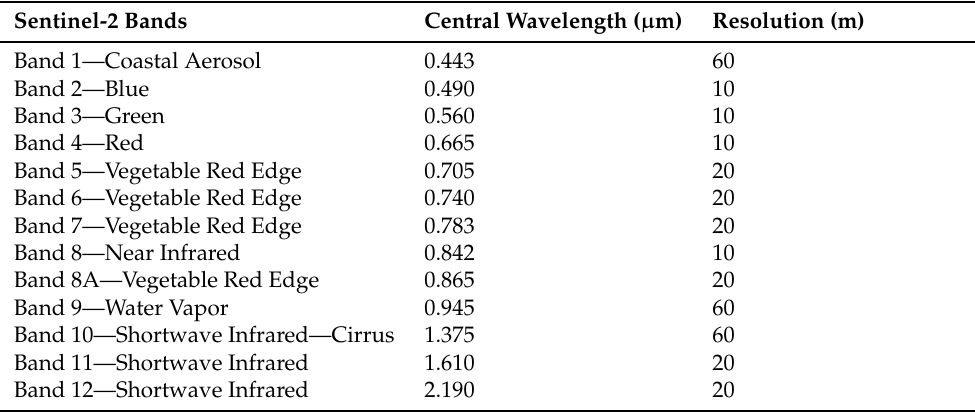
Table 1. Sentinel-2